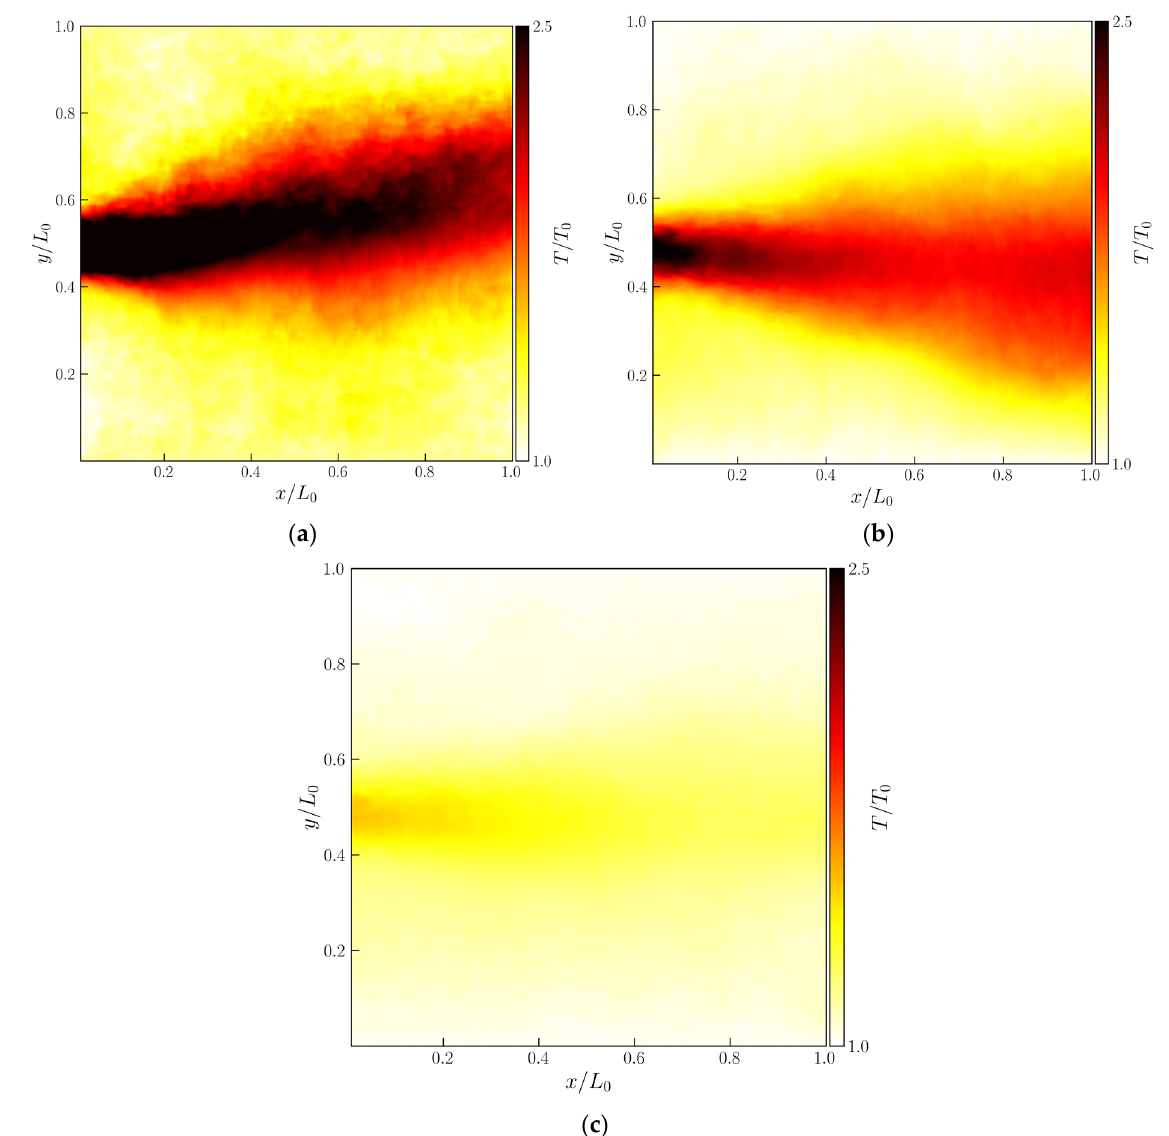
Figure 6. Plasma-induced flow temperature field, at a steady state, for actuators made of Kapton with different dielectric thicknesses, ( a ) 0.3 mm; ( b ) 0.6 mm; ( c ) 1.02 mm, all operating at 7 kV pp and 24 kHz.